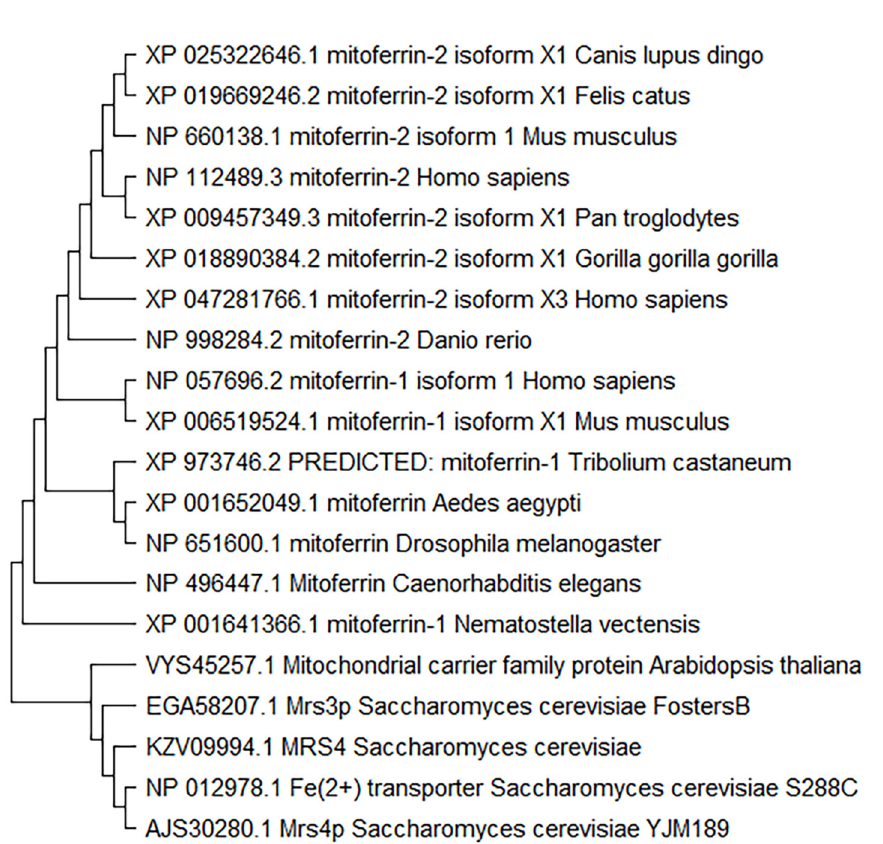
Figure 4. Maximum likelihood phylogenetic tree of Mitoferrin-2 protein sequences. The length of the branches indicates evolutionary time. The protein sequences were selected by BLASTP and aligned using MUSCLE alignment. The maximum likelihood phylogenetic tree was then constructed using MEGAX (v11).